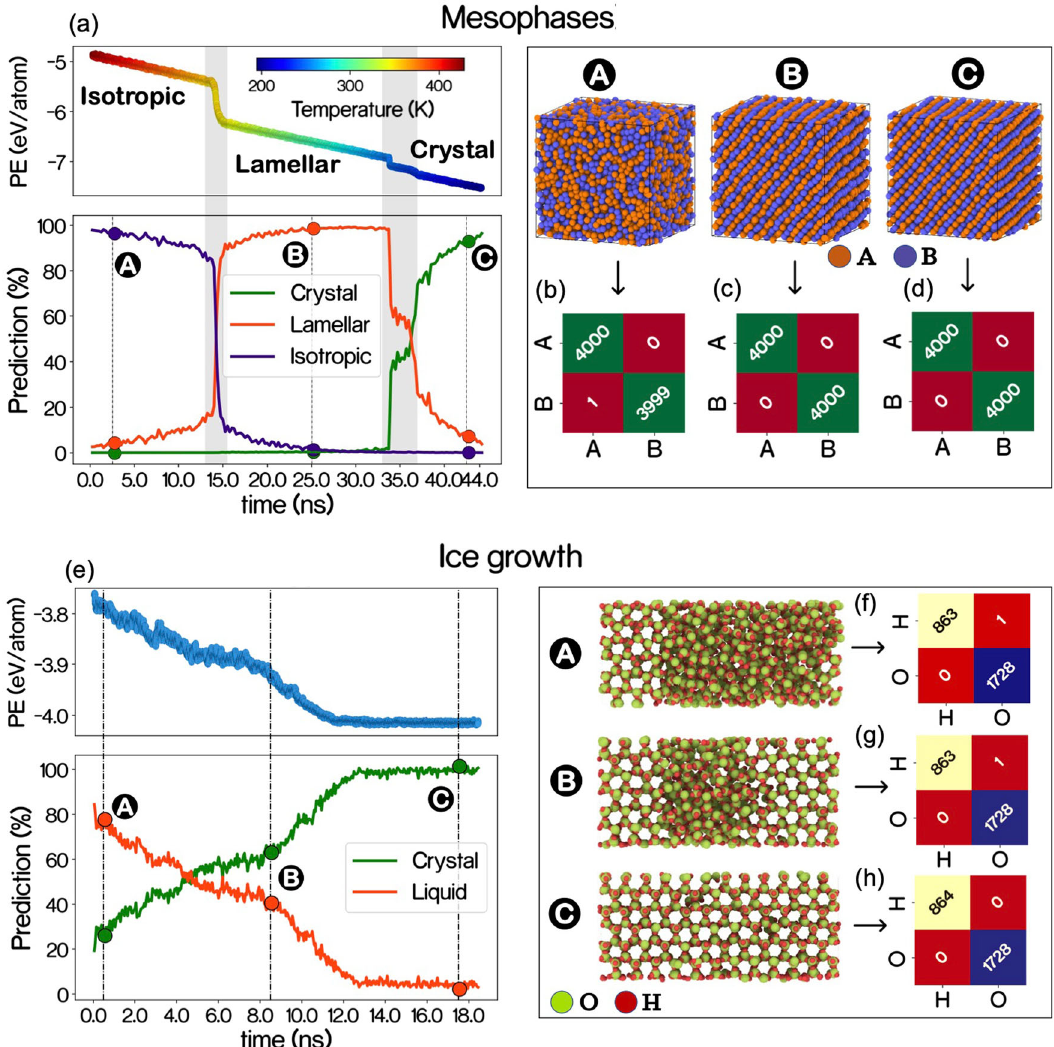
Fig. 8 Multilabel characterization using CEGANN. a Characterization of isotropic liquid, lamellar mesophase, and layered crystal in a binary synthesis mixture. CEGANN identi fi es each phase along the thermal trajectories of phase transformation. Respective potential energy changes with time and corresponding predictions of existing phases by CEGANN ( b – d ) are the confusion matrix of the overall chemical species predicted by CEGANN at different time steps (A, B, C) for mesophase characterization. e Predicting the growth of ice from liquid at 235 K, along with the atoms ( “ H ” & “ O ” ) present in the system (Multilabel). f – h are the confusion matrix of the atomic species predicted at different time steps (A, B, C) as the system is